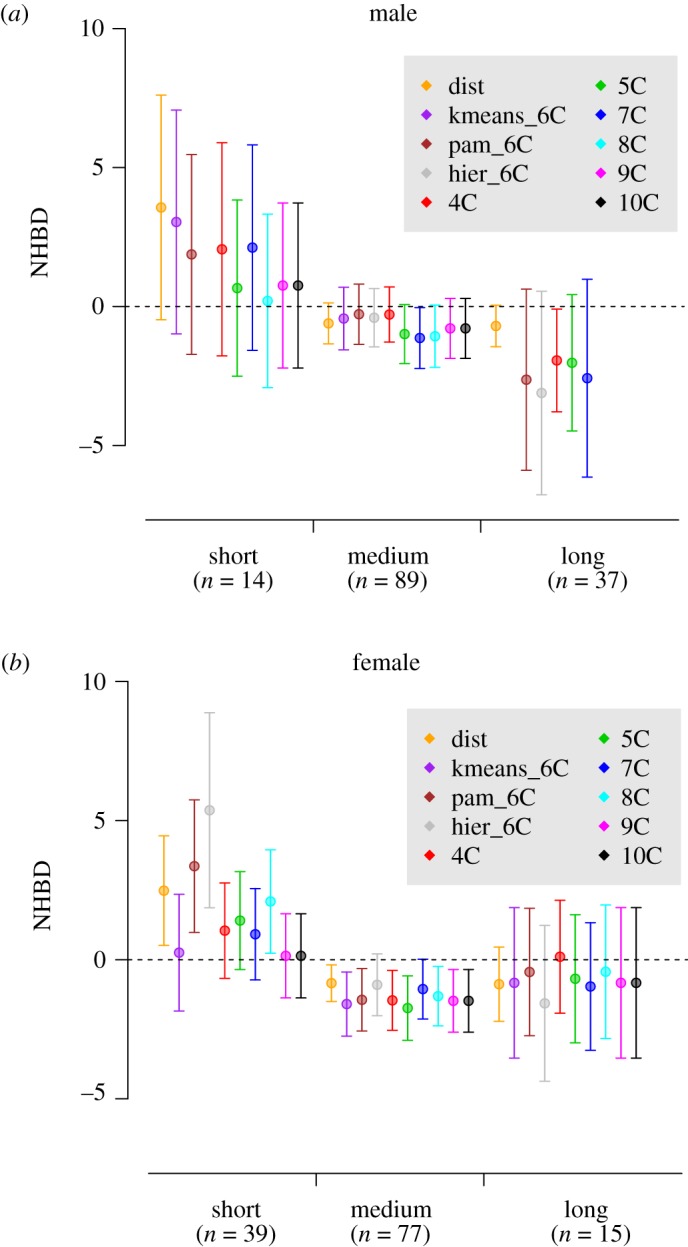
Coefficients (β) and 95% confidence intervals (CI) of NHBD for male (a) and female (b) grey wolves in Scandinavia (1998–2012). Values > 0 represents selection and values < 0 represents avoidance of habitat characteristics similar to the natal one when establishing. Availability was quantified by using CRW. Parameters were estimated from the conditional logistic regressions for short (less than 40 km), medium (40–200 km) and long (more than 200 km) dispersers. For each dispersing distance category the NHBD β coefficients for the different methods of defining habitat similarity are represented by different colours: Distance similarity metric (dist), cluster division from 4 to 10 clusters with (K-means kmeans_6C, 4C–10C), and 6-cluster division with Hierarchical Clustering Methods (hier_6C) and PAM (pam_6C). For long dispersers, 8C and 9C are not shown in the Figure, because of convergence issues. See electronic supplementary material, appendix 4 for further details on the use of different habitat similarity metrics. The β values for the dist metric were multiplied by 100 for readability purposes in this figure.